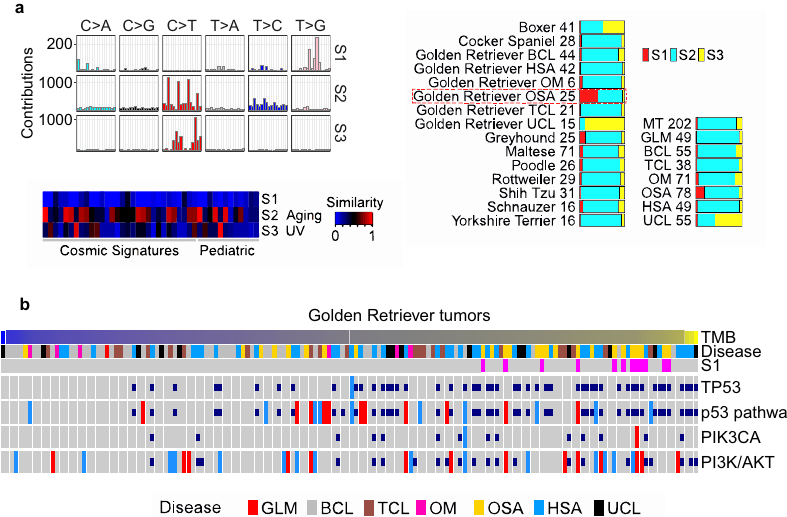
Fig. 8 Golden Retrievers harbor a unique mutation signature that is osteosarcoma-enriched, TMB-associated, and TP53 mutation-independent. a Three mutation signatures were detected in CDS regions of 597 canine tumors from the WES dataset. Right bars indicate the distribution of the three signatures in each tumor type and each validated breed, with the numbers denoting the tumor counts. Left plots indicate the 96 base substitution patterns 6 (top) and the cosine similarity scores between each canine signature and each of the 30 COSMIC 6 and 12 pediatric 7,8 signatures (bottom). b Golden Retriever-speci fi c oncoprint, including 154 animals and presented as described in Fig. 5. Source data are provided as a Source Data fi